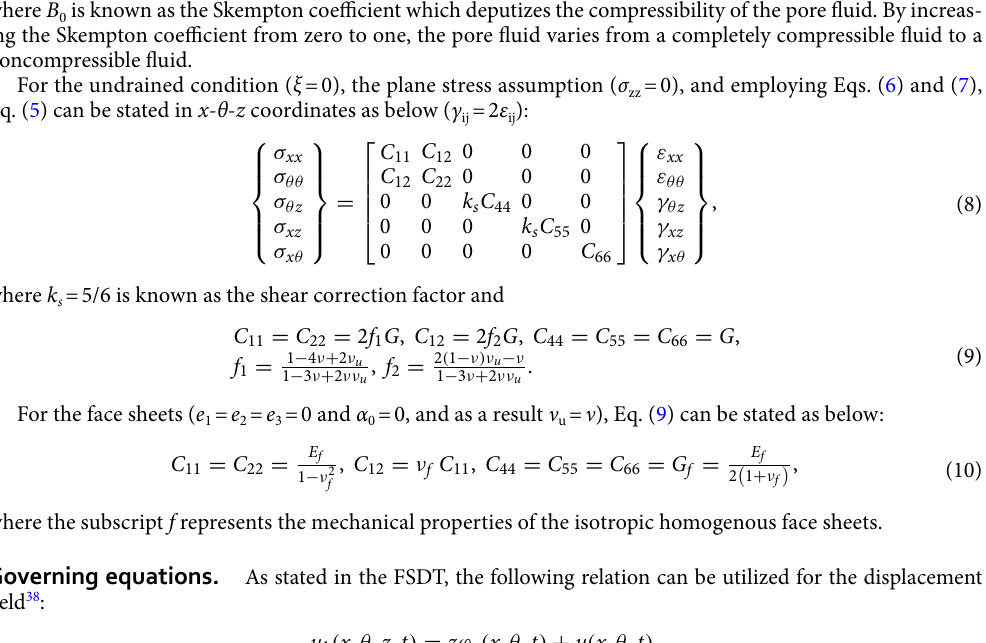
in which ξ stands for the variation of fluid volume content and ν u and M sequentially represent undrained Pois- son’s ratio and Biot’s modulus and are defined as below: